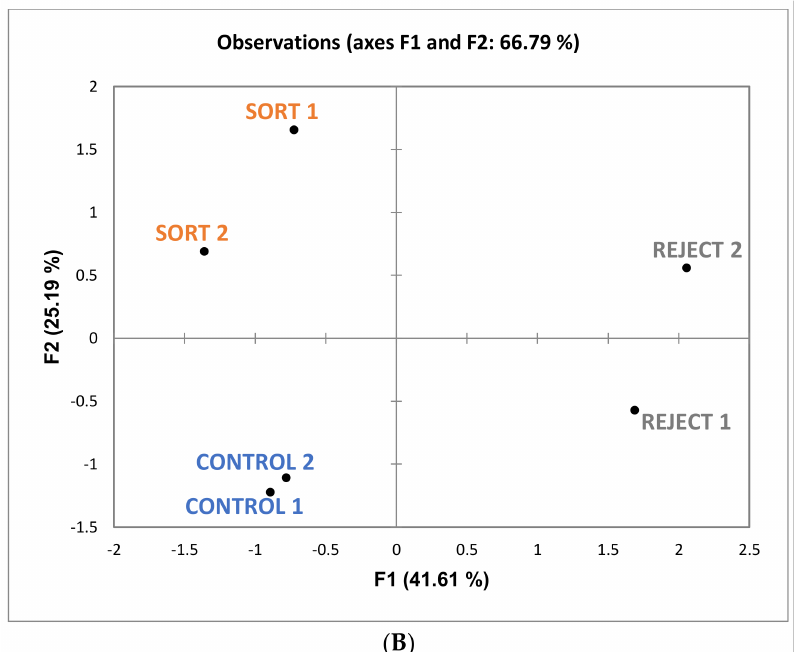
Figure 8. Loadings ( A ) and score ( B ) plots of a multiple factor analysis (MFA) between volatile com- pounds (blue) in Barbera wines that differed significantly, and all sensory attributes (red) generated from the respective descriptive analysis panel. Only biological replications consistent with those for sensory were included in the MFA.